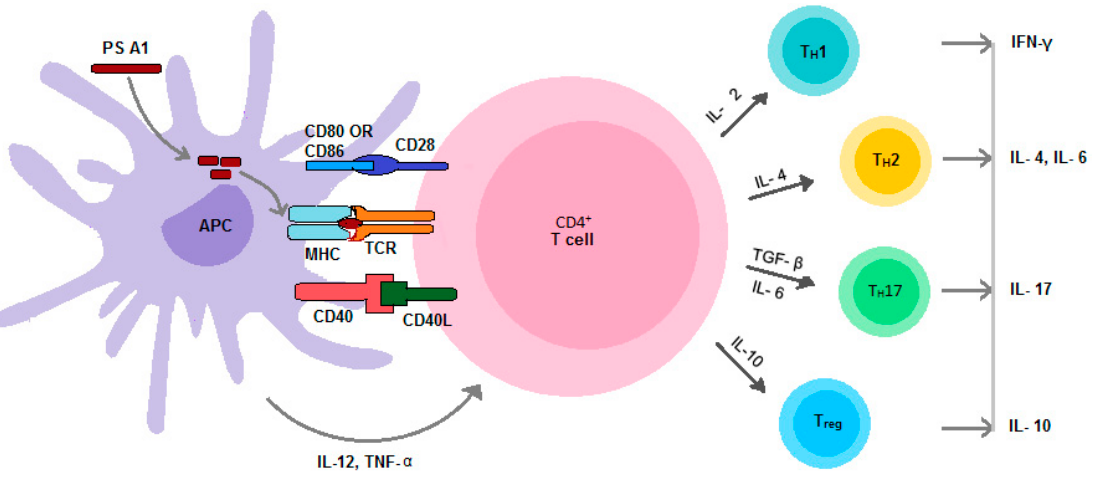
Figure 3. Activation and differentiation of CD4+ T-cells.